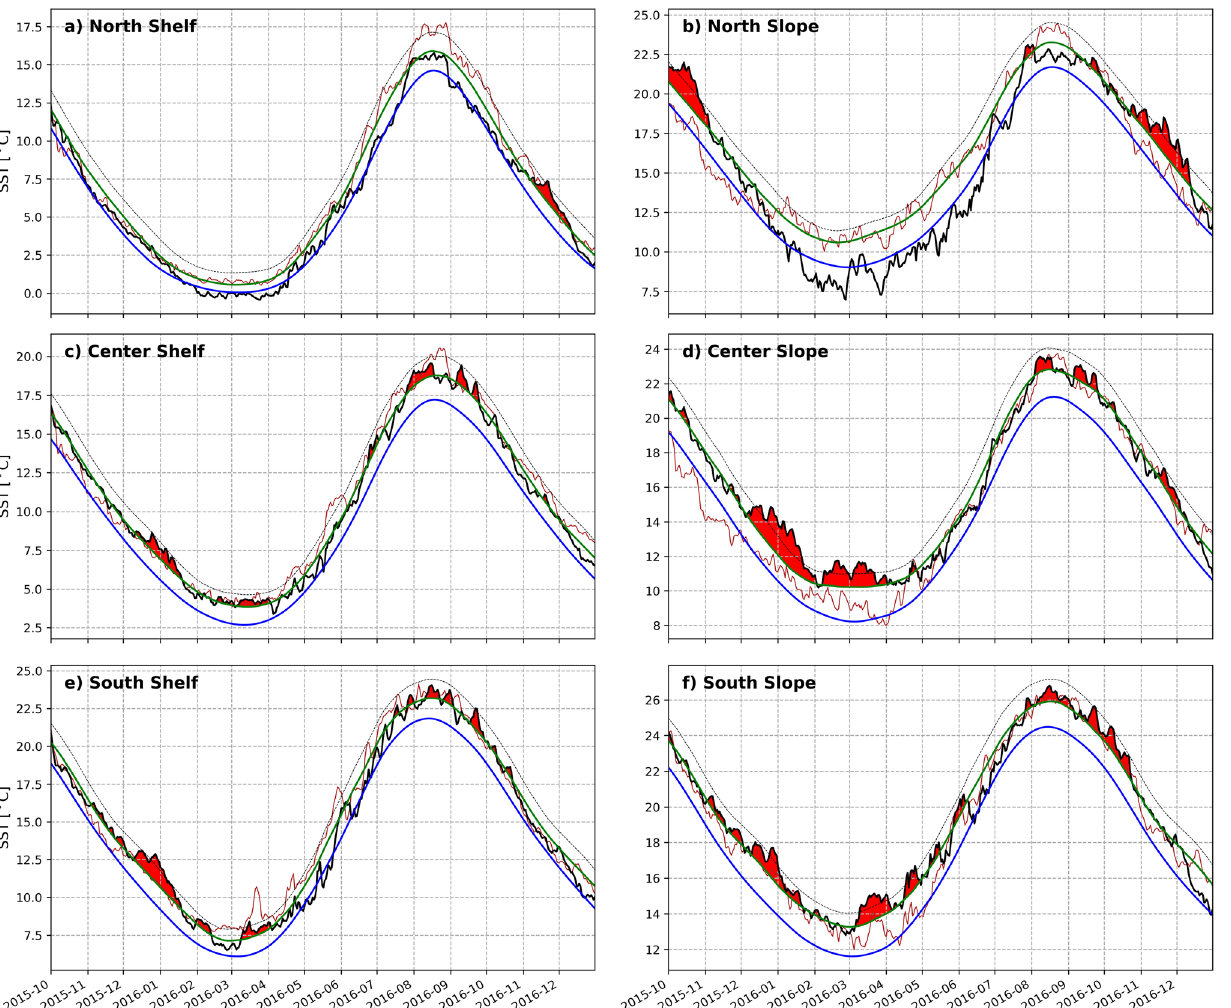
Figure 2. Evolution of the daily SST within sub-regions for October 2015 to December 2016 (black lines). The October 2011 to December 2012 SSTs are shown for comparison (red line). The blue line is the climatology based on a 30-year period (1986–2016). The green line is the threshold (90th percentile), as described in Hobday et al. 19,20 . The dashed line is twice the threshold, which categorizes a ‘strong’ MHW category. The red shading indicates a MHW. Note that the y-axes for all plots are different to increase visibility, since SST varies greatly from north to